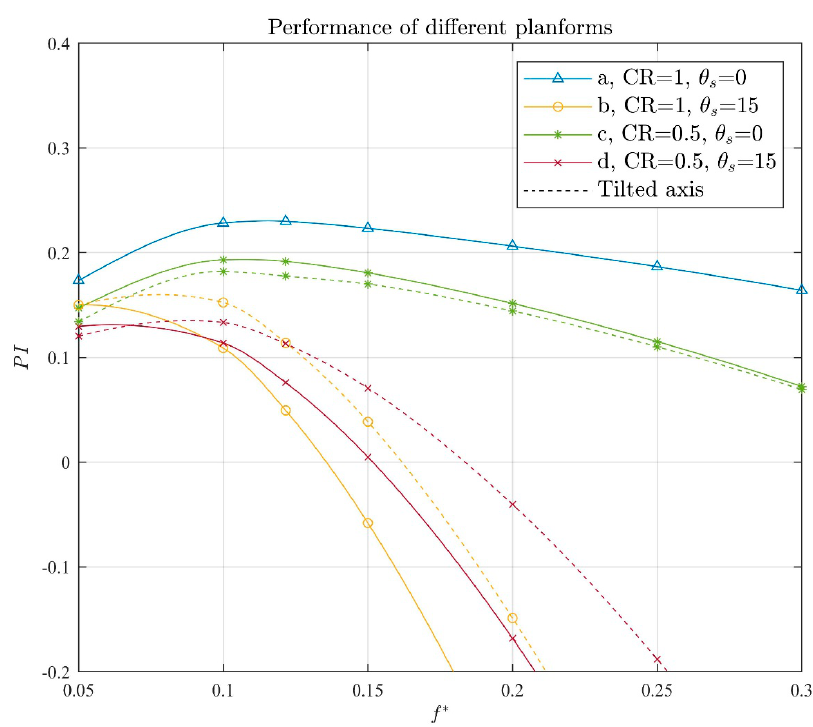
Figure 13. Comparison of the performance for the cases (a), (b), (c) and (d). Results for both straight and tilted pivot axes are shown.